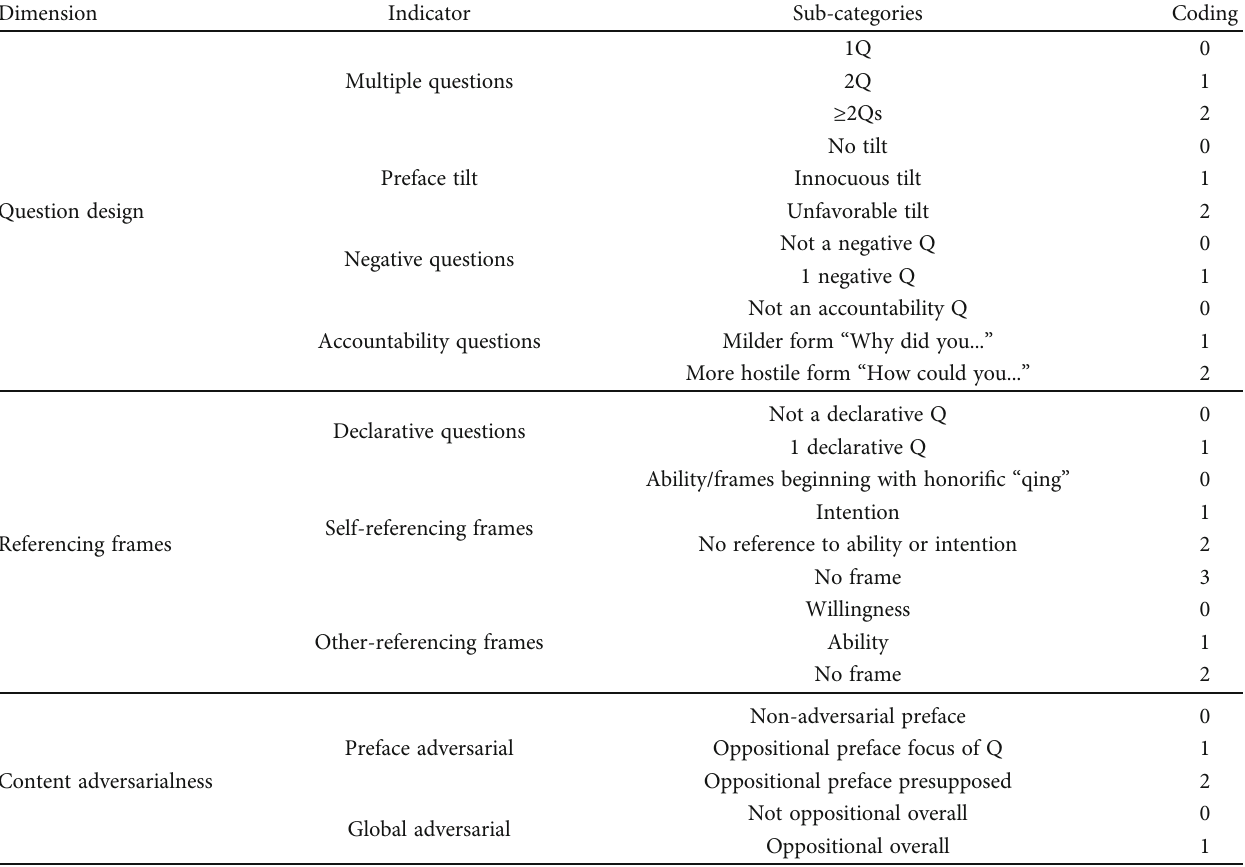
Table 2: The revised question analysis